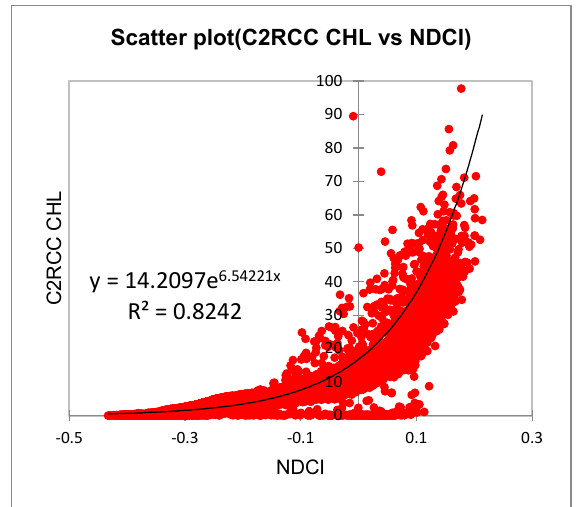
Figure 3. Scatterplot for the sample NDCI values and